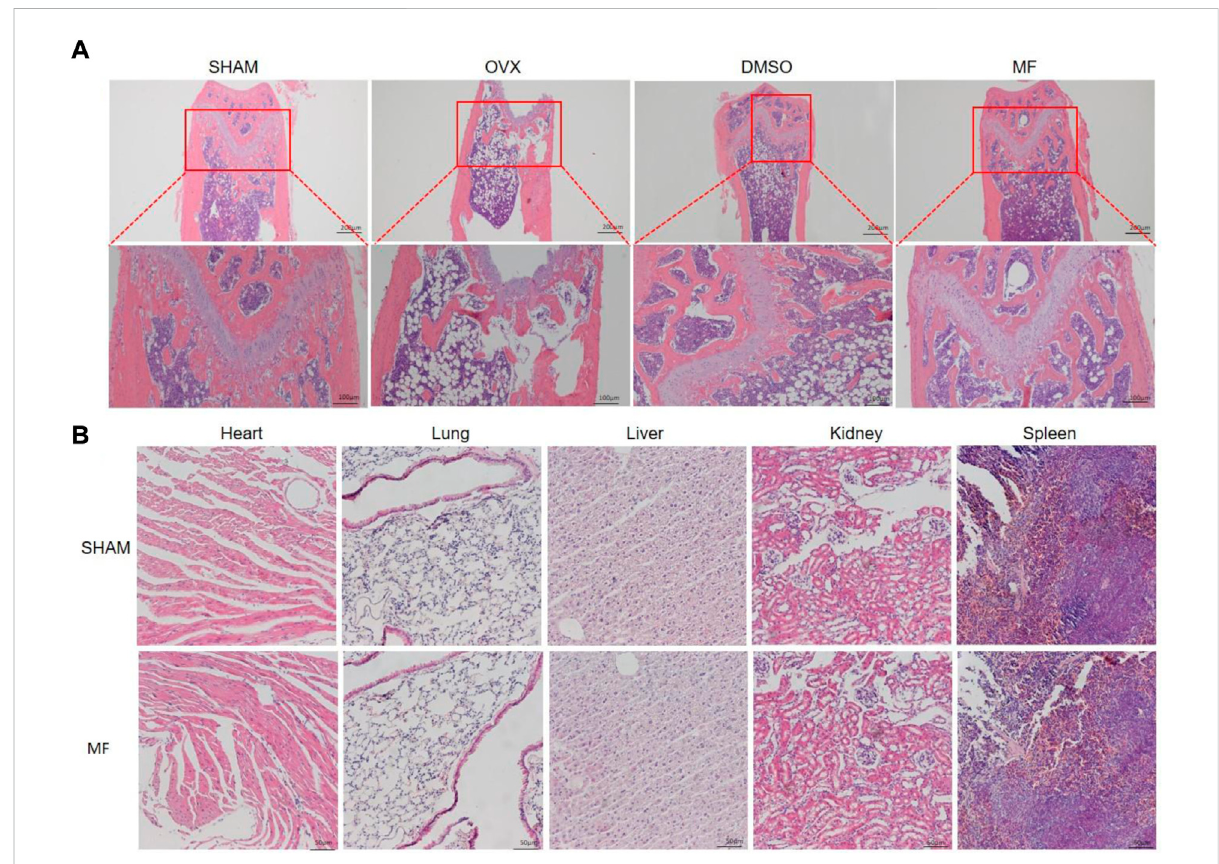
FIGURE 6 HandEstainingofthefemurofOVXmice. (A) trabecularbonewasrupturedandscatteredintheOVXandDMSOgroups,whilethepathological changesinthemangiferingroupwerelesssevere thanthat oftheOVX group. (B) Hand Estainingoftheheart,lung,liver, kidney,and spleenshowed that the mangiferin has no obvious organ toxicity. Note: MF,